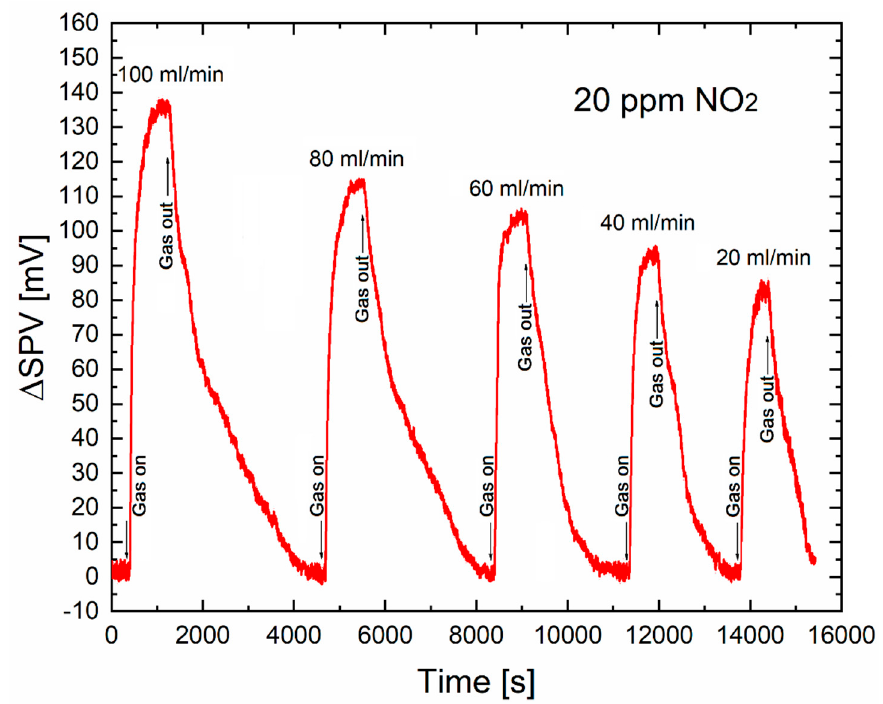
Figure 2. The time-dependent variation of amplitude of SPV signal in NO 2 at various gas flow rates, and at a constant relative concentration of 20 ppm in synthetic air.